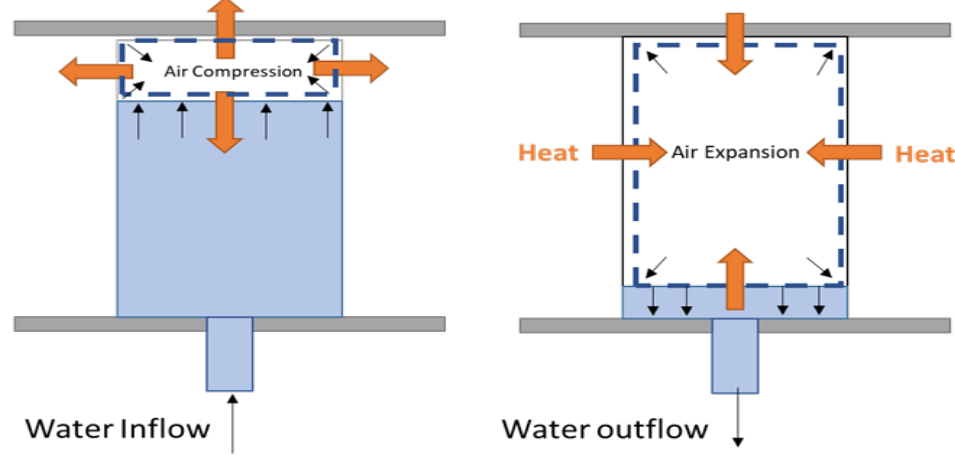
Figure 9. Schematic diagram of a liquid